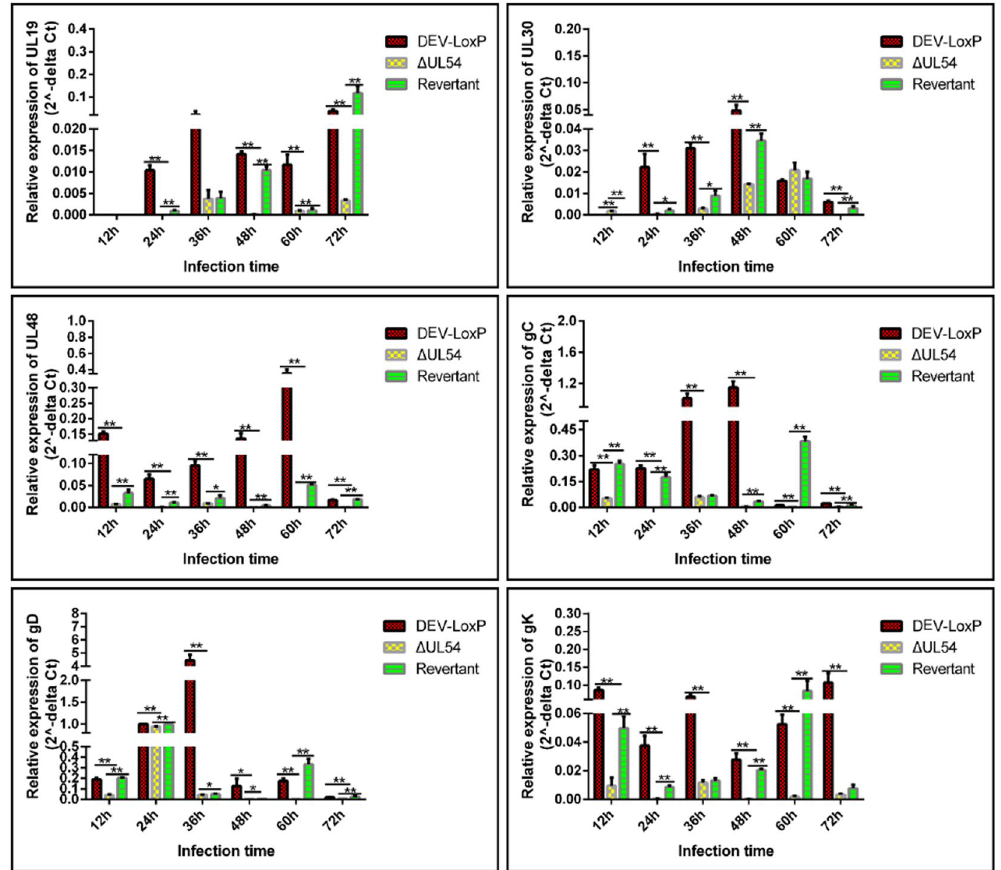
Figure 5. Regulation of DEV UL54 on viral gene transcription. DEFs were infected with DEV-LoxP, DEV- Δ UL54 or DEV- Δ UL54 (Revertant) at 200 TCID 50 and the nuclei were extracted. After a nuclear run-off